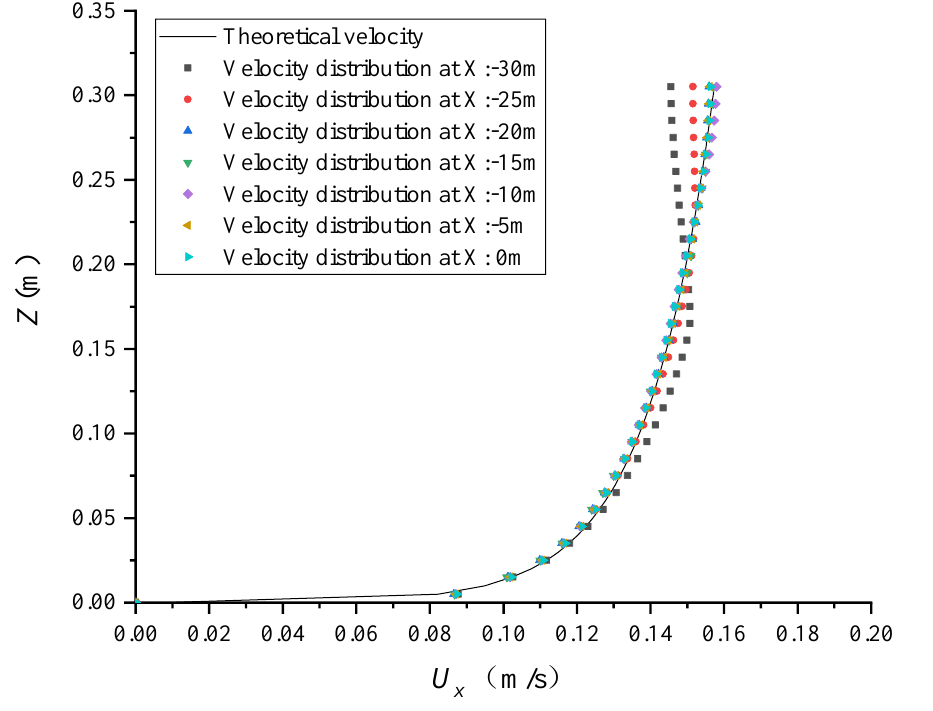
Figure 5. Velocity distribution along the Z-direction at different X positions.